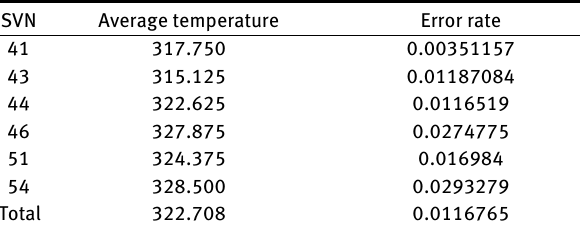
Table 7. Average temperature and error rate of GPS Block IIR solar panel temperature